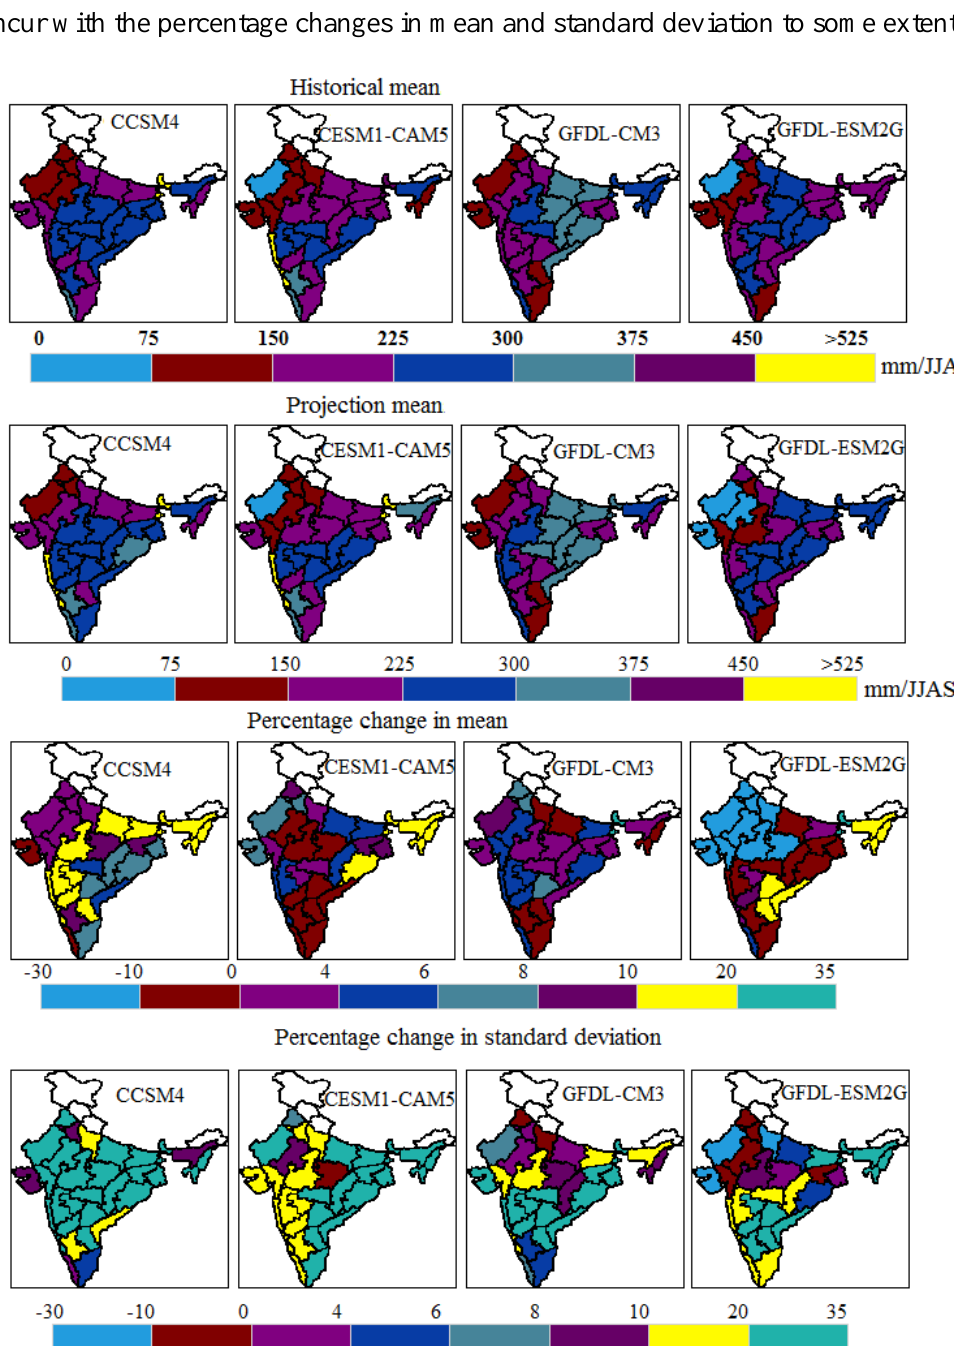
Figure 7. Comparison of the graphical patterns of means of four optimum models across meteorological subdivisions of